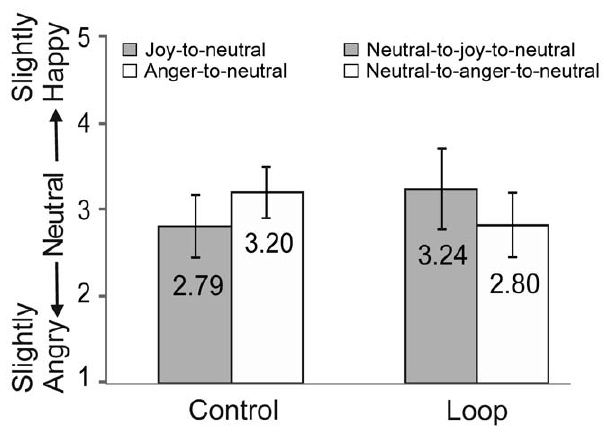
Figure 6. Results of Experiment 3. Ratings of the neutral expressions at the end of the video-sequences in the Control and Loop conditions. Error bars indicate 6 1SD.